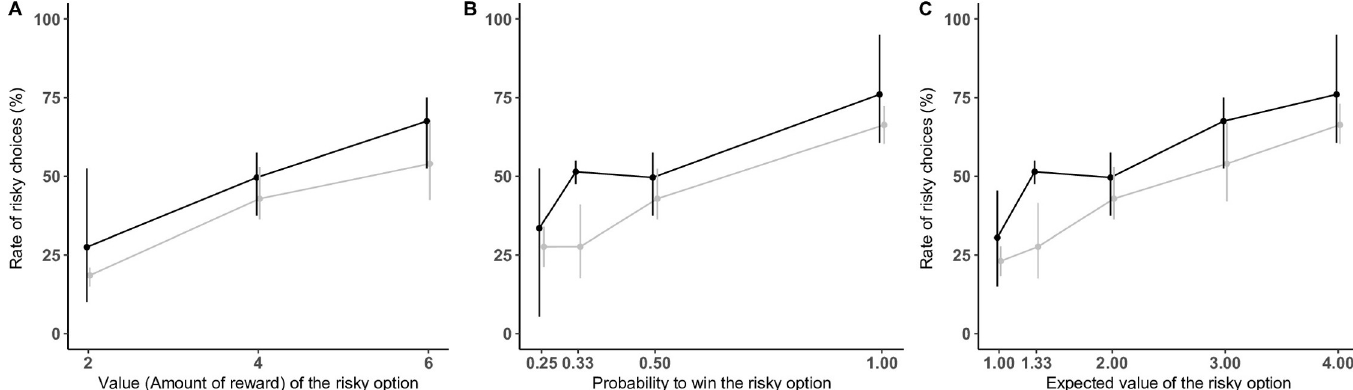
Fig 2. Results of Experiment 1. Mean percentage of trials where subjects selected the risky option according to the value of the risky option (A) the probability to win (B) and the expected value of the risky option (C) for gorillas (black) and orang-utans (grey). Error bars indicate 95% confidence intervals.